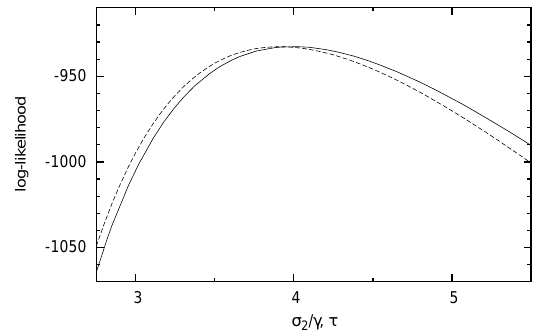
Fig. 6. Ice-core data: Log-likelihood as a function of σ 2 /γ for the oscillator model (solid) and as a function of τ for the one- dimensional potential model (dashed). the structural model error. The problem is removed by apply- ing the constraint that the mean state of the model matches the mean state of the data (cf. Kwasniok and Lohmann, R ∞ zp(z) d z = 0, leading to the condi- 2009), that is, h z i = −∞ tion (cf. Eq.